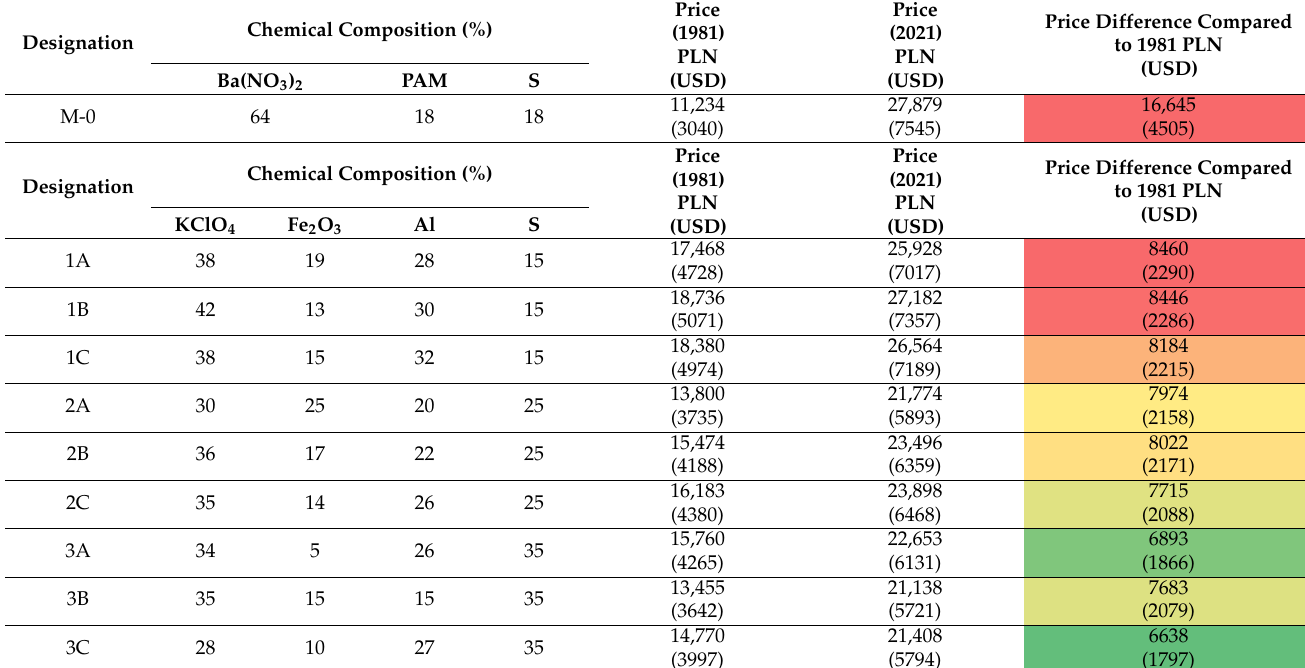
Table 9. Comparison of manufacturing costs of pyrotechnic compositions from the M-1 group for model 1, batch of 500 kg (1102 lb) of pyrotechnic compositions.